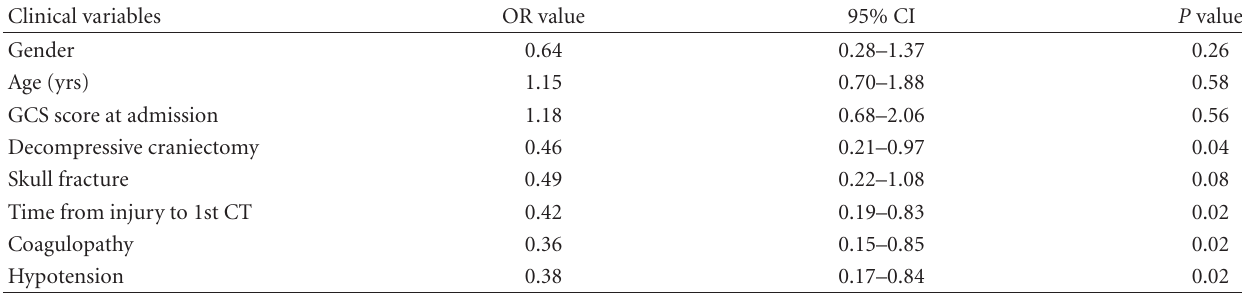
Table 3: Multivariate logistic regression analysis of the association between risk factors and PEDH. Clinical